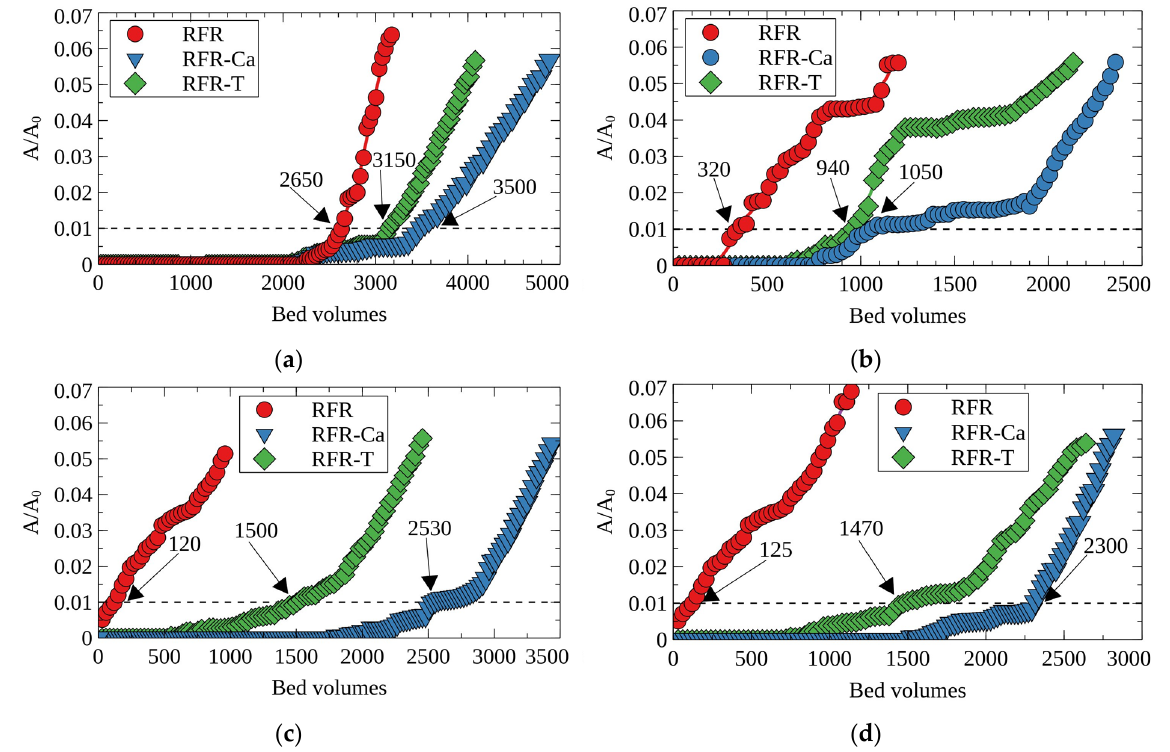
Figure 9. Effects of cations on the efficiency of Cs-137 removal by RFRs until the 5% breakthrough under dynamic conditions; ( a ) Na + , ( b ) K + , ( c ) Mg 2+ , ( d ) Ca 2+ , concentration 0.1 mol·eq/L, pH 9, grain